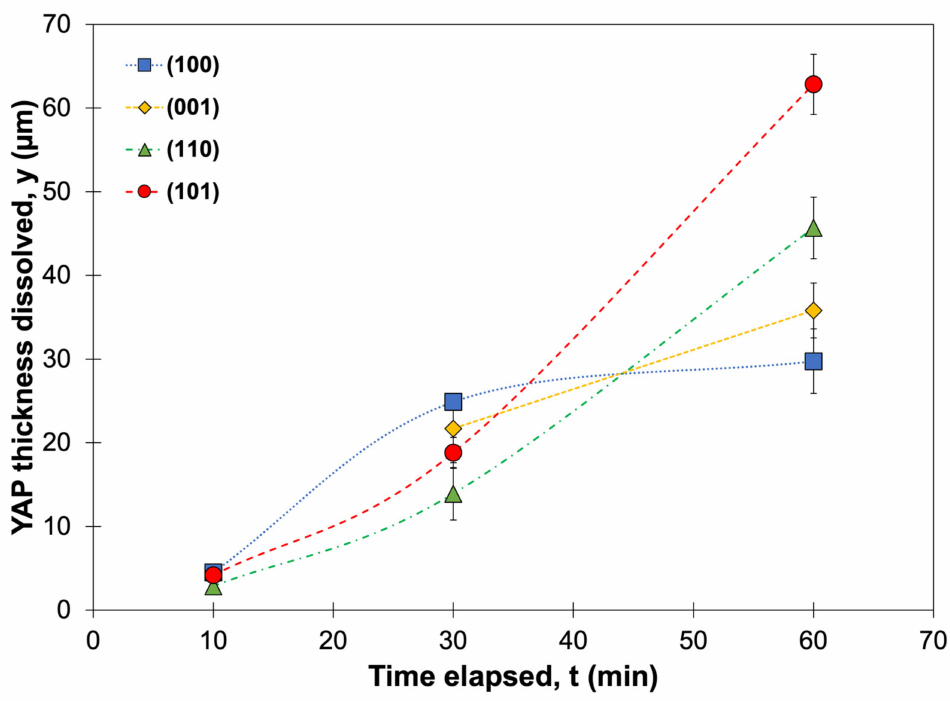
Figure 4. The YAP substrate thicknesses measured after reacting with CMAS for various times at 1350 ◦ C. Error bars indicate the standard deviation of the measurements collected using